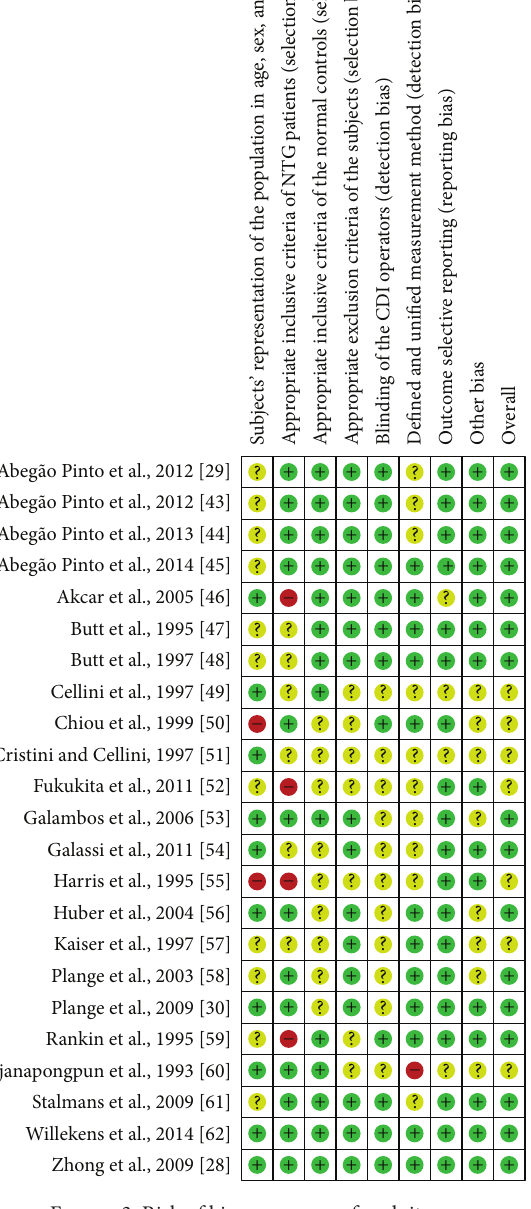
Figure 3: Risk of bias summary of each